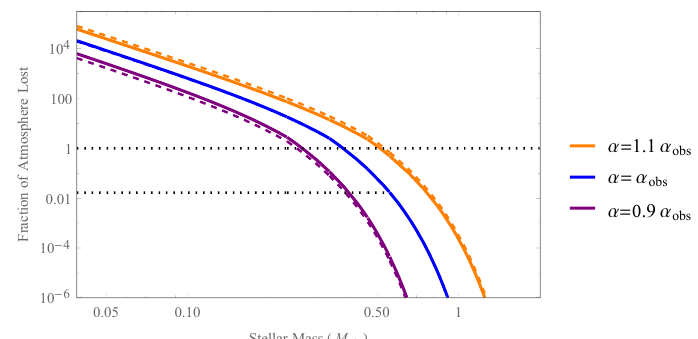
Figure 1. Fraction of atmosphere lost as a function of stellar mass. The dependence of this quantity on the fine structure constant α can be observed. The solid lines assume a late atmospheric delivery scenario, and the dashed lines assume atmosphere originates in original accretion. The dotted lines correspond to the catastrophic value 1, and the Sun’s